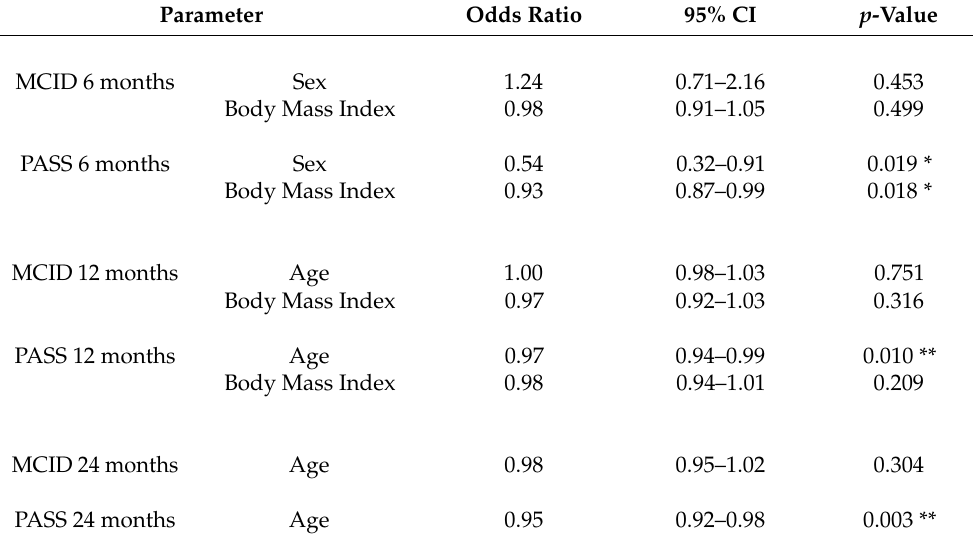
Table 4. Analysis of correlation with postoperative MCID and PASS. Binary logistic regression analysis (backward stepwise elimination) of factors identified as significantly affecting postoperative iHOT-33 and achievement of the MCID and the PASS. iHOT-33, International Hip Outcome Tool (33 items); MCID, minimal clinically important difference; PASS, patient acceptable symptom